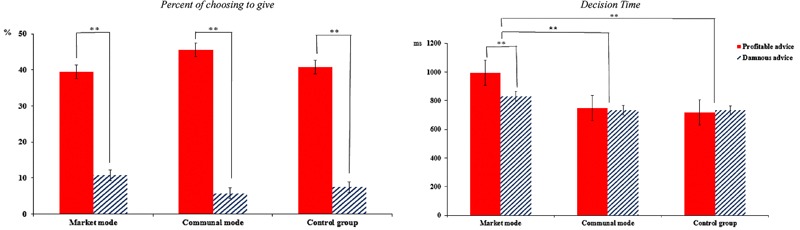
The proportion of choosing to give and the decision time for each condition. ∗∗p < 0.01.